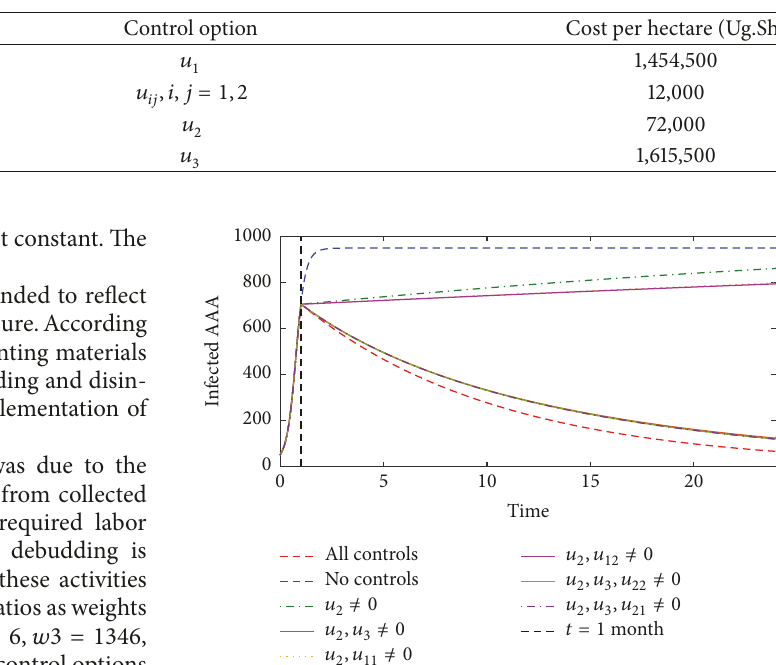
Table 2: Table showing costs of implementations of control options [19].